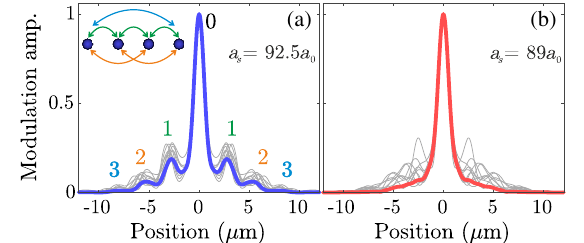
FIG. 4. Evaluation of the coherence between neighboring droplets. Absolute value of the Fourier transform of the integrated interference patterns after 30 ms time of flight, showing signs of the multiple frequencies of the interference due to nearest- neighbor, next-nearest-neighbor, and even higher-order coher- ence. This is schematically shown in the inset of (a). The gray lines correspond to single-shot realizations and the blue lines to the mean of all available realizations for a given atom number for a ¼ 92 . 5 a a ¼ 89 a s 0 [(a), blue] and s 0 [(b), red]. In the latter case, the position of the side peaks changes randomly (b), while in the coherent droplet regime (a), the side peaks appear at the same position in every realization and show very little variance in their amplitude. This provides clear evidence for the phase coherence between the droplets (a), with the variance of the peak height of the first side peak corresponding to nearest-neighbor coherence, the second peak corresponding to next-nearest- neighbor coherence, and the third to next-next-nearest-neighbor coherence. The shown exemplary Fourier transforms correspond to the red points in Figs. 5(b) and 5(c).